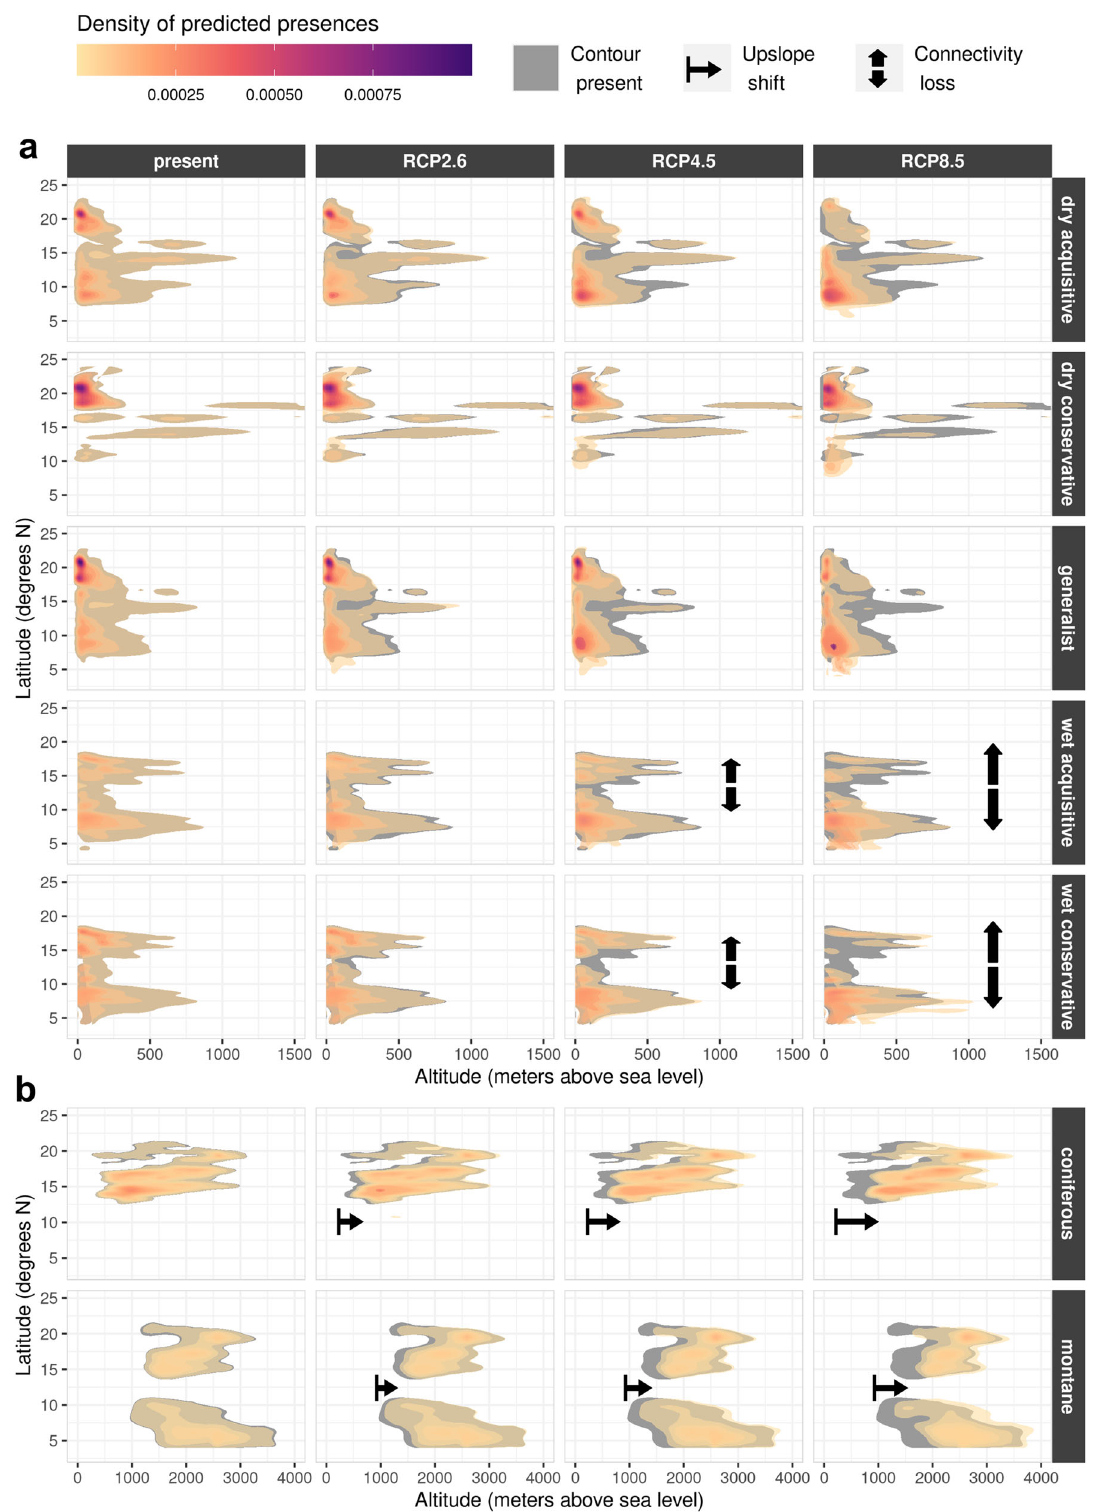
Fig. 2 Latitude-altitude suitability shifts. Density plot of projected PFT presences (bS-SDM ≥ 2) across latitudinal and altitudinal gradients ( a : lowland types, b : coniferous/montane types). Columns 2-4 show CCSM4 scenario projections with grey shading of the contour of column 1 (present). Accordingly, fully visible grey contours highlight zones, which may be lost in the respective scenarios. Diverging arrows mark scenarios where connectivity losses appeared (arrow length symbolizes strength), while right-facing arrows represent the strength of upslope shifts of the lower boundary of the density clouds (trend towards mountaintop